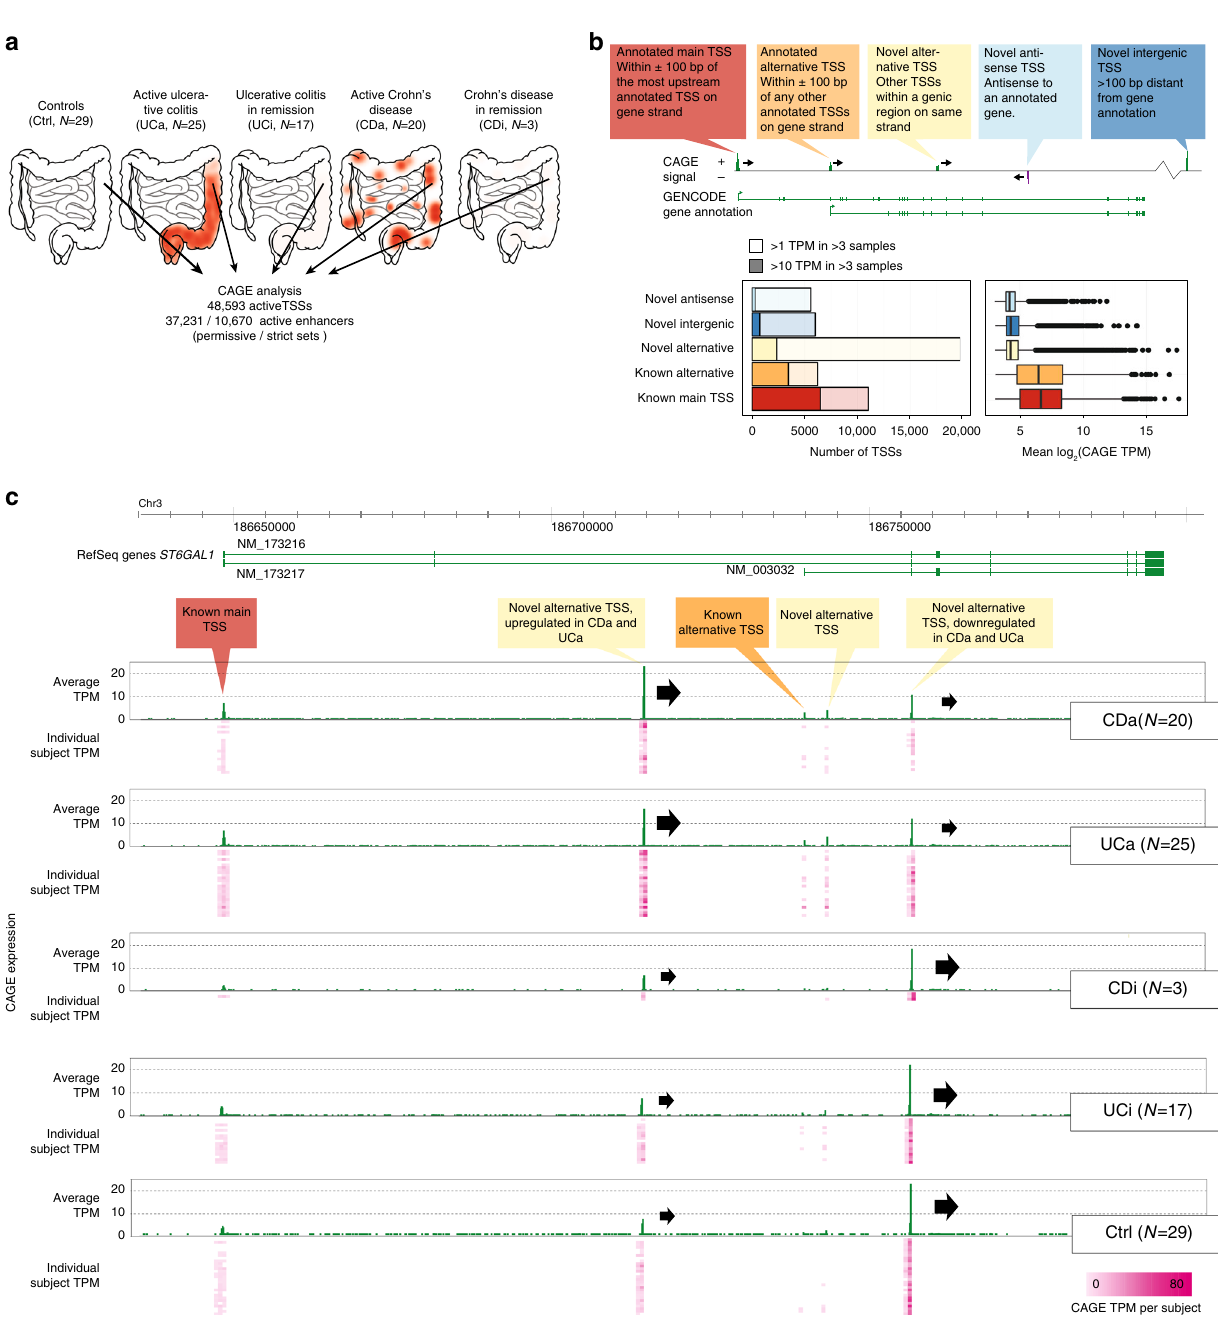
Fig. 1 De fi ning the TSS landscape of IBD. a Overview of data set. Pinch biopsies from the descending colon were taken from 94 human subjects, classi fi ed into active ulcerative colitis (UCa), active Crohn ’ s disease (CDa), UC and CD patients in remission (UCi, CDi) and controls (Ctrl: subjects screened for IBD where all subsequent investigations turned out normal). For each biopsy, a CAGE library was produced, resulting in the detection of TSSs and enhancer regions. Schematics show the typical in fl ammatory patterns in the intestinal system, the approximate location of biopsy sampling and number of subjects in each group. b Detection and annotation of gene TSSs. Top panel shows an example gene with CAGE-de fi ned TSSs, which are annotated as main, alternative or novel TSSs de fi ned by their overlap with GENCODE gene annotation as indicated in callouts. CAGE-de fi ned TSSs not falling into any of the categories were de fi ned as novel intergenic TSSs. Left bottom panel shows the number of detected TSSs in each category (colors correspond to callouts in top panel), split by CAGE expression strength measured as tags per million (TPM). Right bottom panel shows the expression distribution of each category of TSSs as boxplots. c Genome-browser example of the detection of annotated and novel TSSs in the ST6GAL1 gene. From top to bottom, the browser plot shows the genomic location investigated, RefSeq gene annotation (exons are denoted as boxes, green indicate forward strand transcription). Below, CAGE TPM expression on the forward strand is shown as average across subjects (green bars) and for individuals (pink heat map, each row is one subject, columns are widened 5× for readability), split by subject group. Annotated and novel TSSs, annotated as in b are highlighted. Note that the fi rst novel alternative TSS is upregulated in CDa and UCa vs. remaining groups, while the last novel alternative TSS has the opposite pattern (block arrows indicate TSSs and their overall strength in each subject group for these two TSSs). Conversely, the annotated TSSs are detected but not substantially changing between